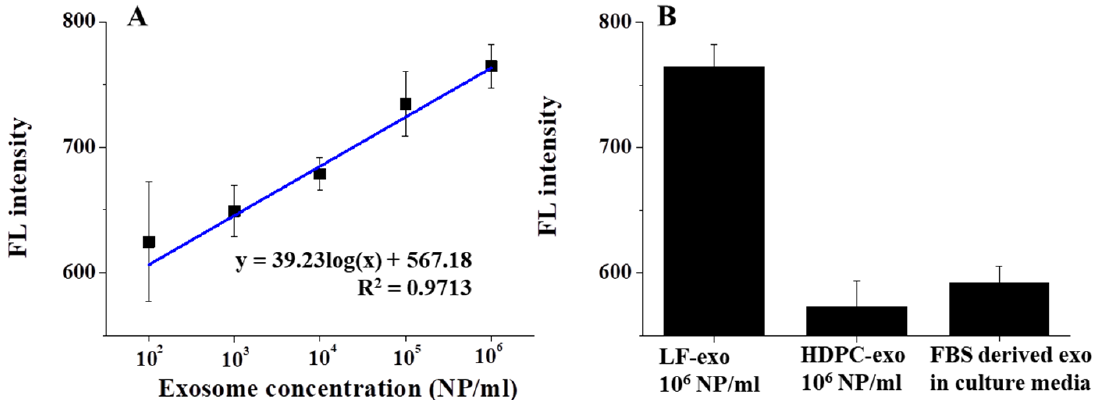
Figure 5. Disease-specific exosome detection performance based on a magnetofluoro-immunoassay using Ag/IO-GRP and AF488-CD9: ( A ) sensitivity test and ( B ) selectivity test against other exo- somes.